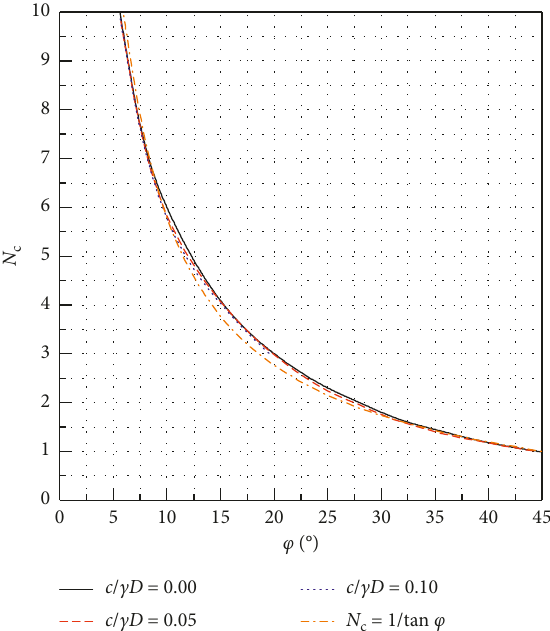
Figure 11: Dimensionless parameter N c for tunnel face